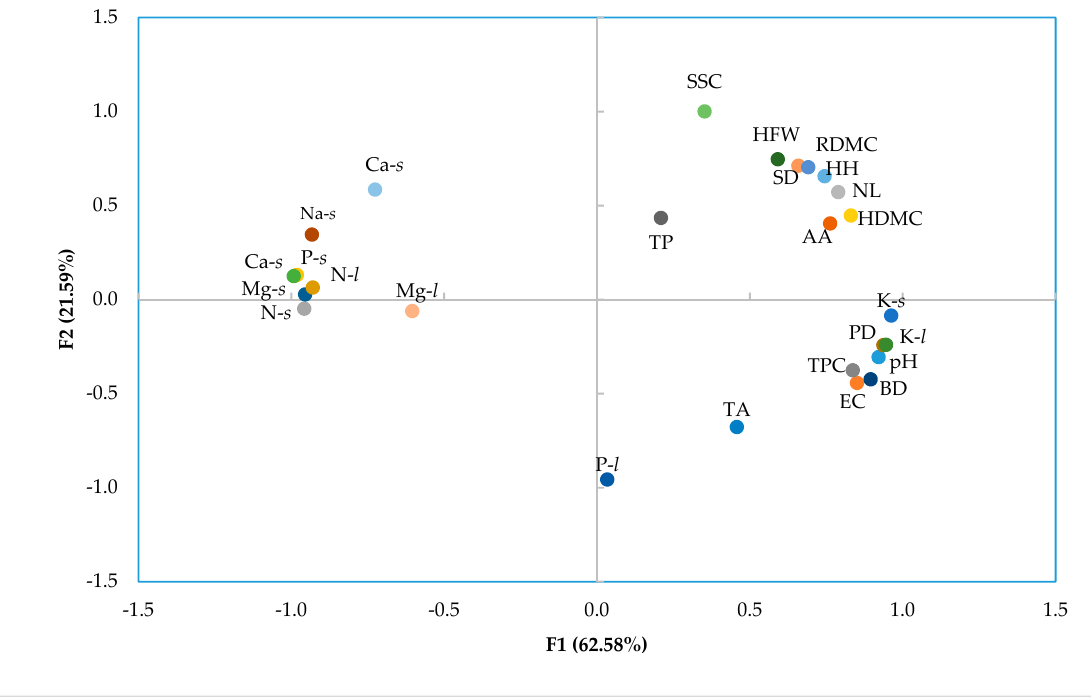
Figure 1. Plot of loadings: substrate traits, agronomic, nutritional and functional properties of curly endive at harvest.